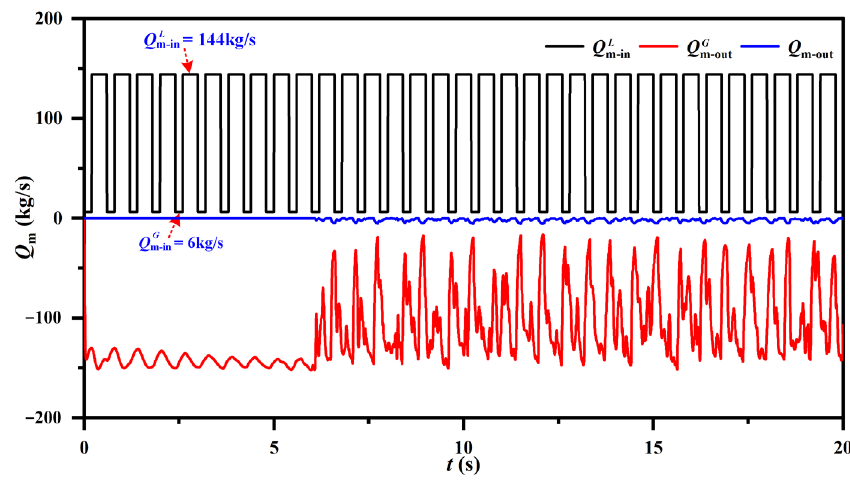
= 6 kg/s = 6 kg/s m-in m − in